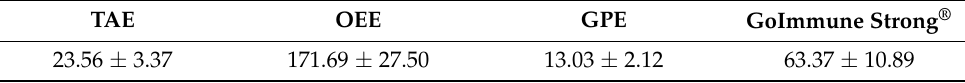
Table 1. Total phenolic content of individual extracts and extract complex, gallic acid equivalents mg/g DW. TAE— Tabebuia avellanedae bark extract; OEE— Olea europaea leaf extract; GPE—green propolis extract. Mean ± SD from three independent